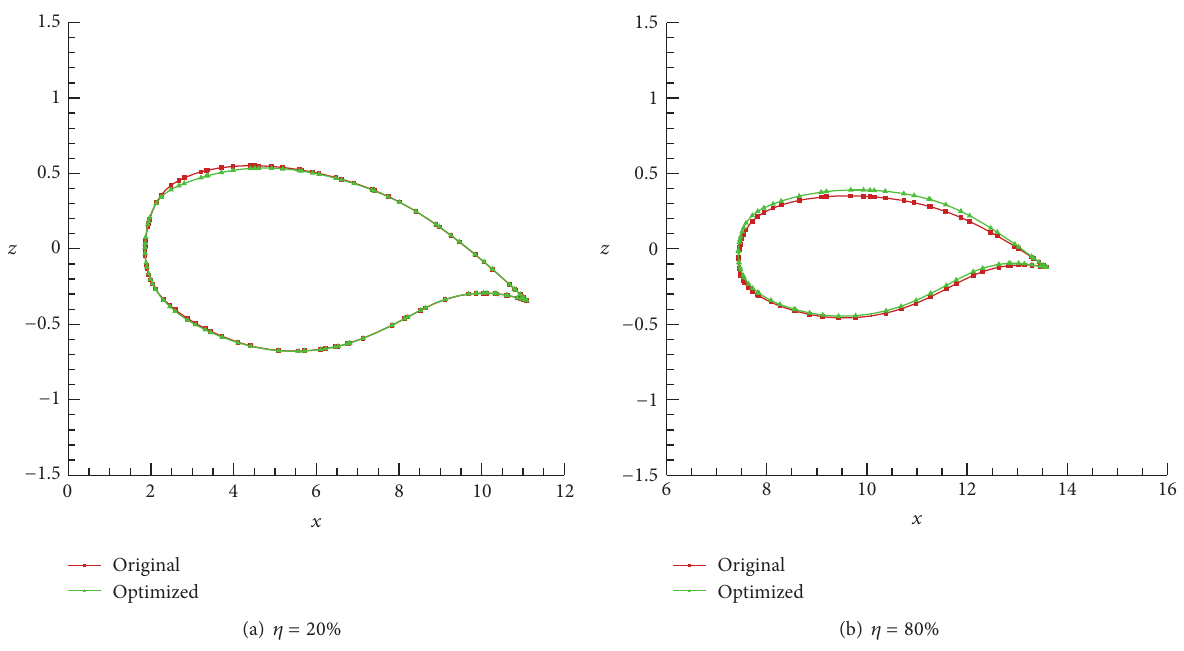
Figure 11: Comparison of section shapes before and after design of rigid